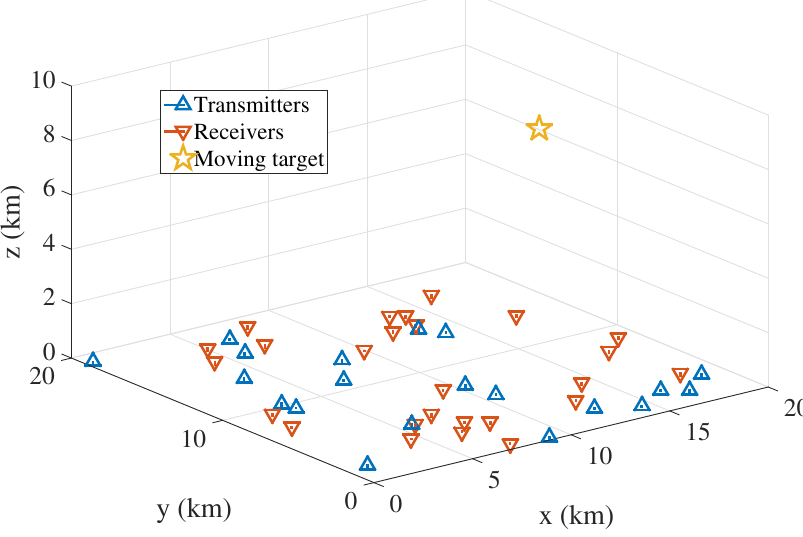
Figure 2. The positions of transmitters, receivers and